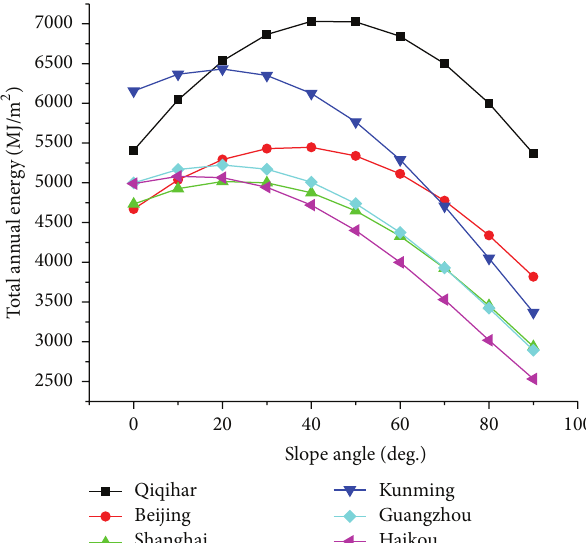
Figure 4: Effect of surface slope on annual solar radiation collection in cities with different geographic